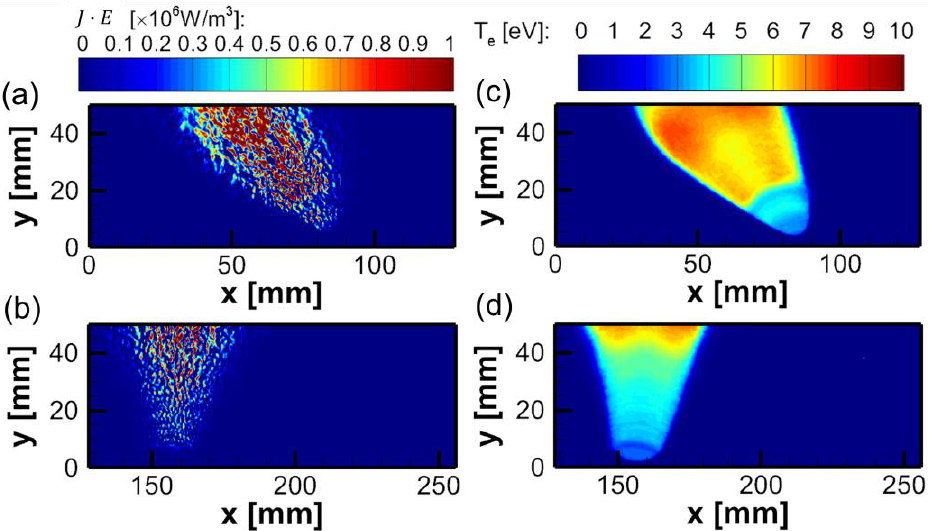
Figure 10. (Left) Profiles of 𝐽 ∙ 𝐸 of the ( a ) left side and ( b ) right side of the domain for the asym- metric case. (Right) Profiles of electron temperatures of ( c ) the left side and ( d ) the right side of the domain in the asymmetric